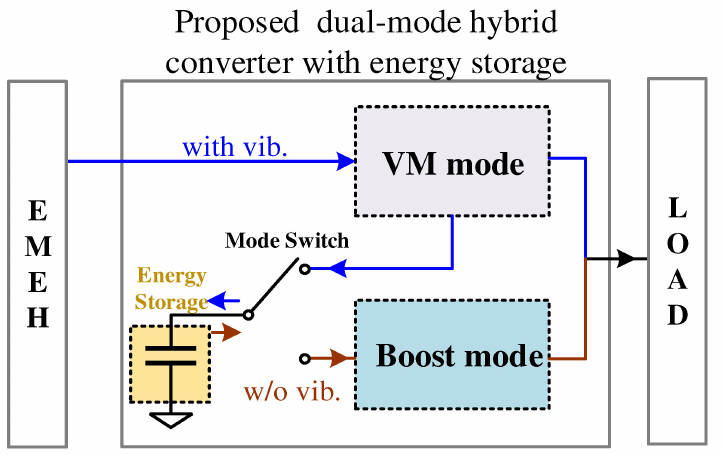
Figure 4. System architecture of the proposed dual-mode hybrid